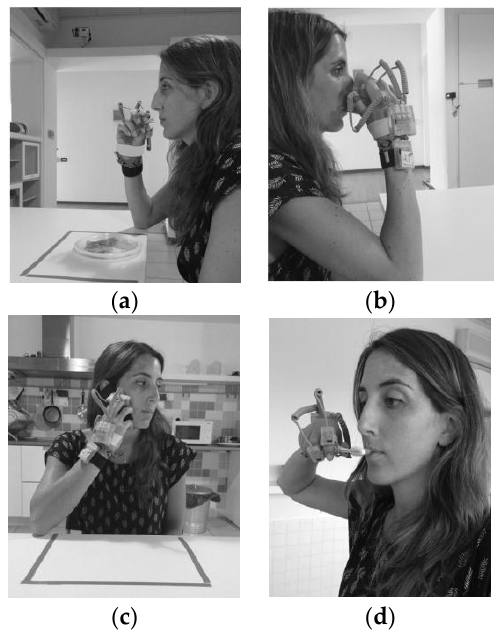
Figure 3. Example of ( a ) eating with the hand gesture (HA); ( b ) drink from the cup (CP); ( c ) answer the telephone (PH); ( d ) brushing the teeth (TB).